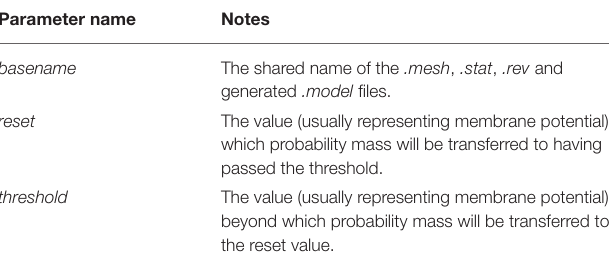
TABLE 2 | Parameters for the generate-model command in the